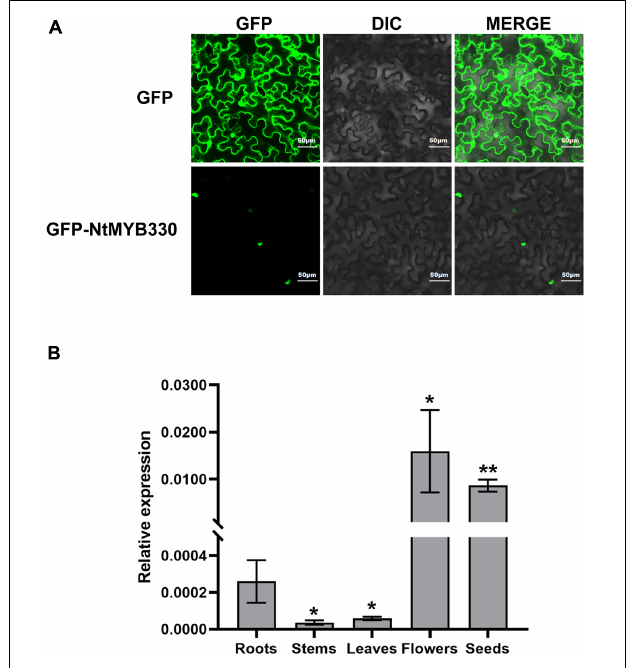
FIGURE 2 | Subcellular localization of NtMYB330 protein and NtMYB330 gene expression pattern. (A) Subcellular localization of GFP-NtMYB330 fusion protein and GFP control in N. benthamiana leaves transformed by Agrobacterium -infiltration. GFP, GFP fluorescence; DIC, differential interference contrast; MERGE, fluorescence and DIC merged images. Scale bar = 50 µ m. (B) Relative expressions of NtMYB330 in different tobacco tissues. Data are the mean of three replicates with error bars indicating ± SD. Asterisks indicate statistically significant differences from Roots according to paired t -test (* P < 0.05; ** P <